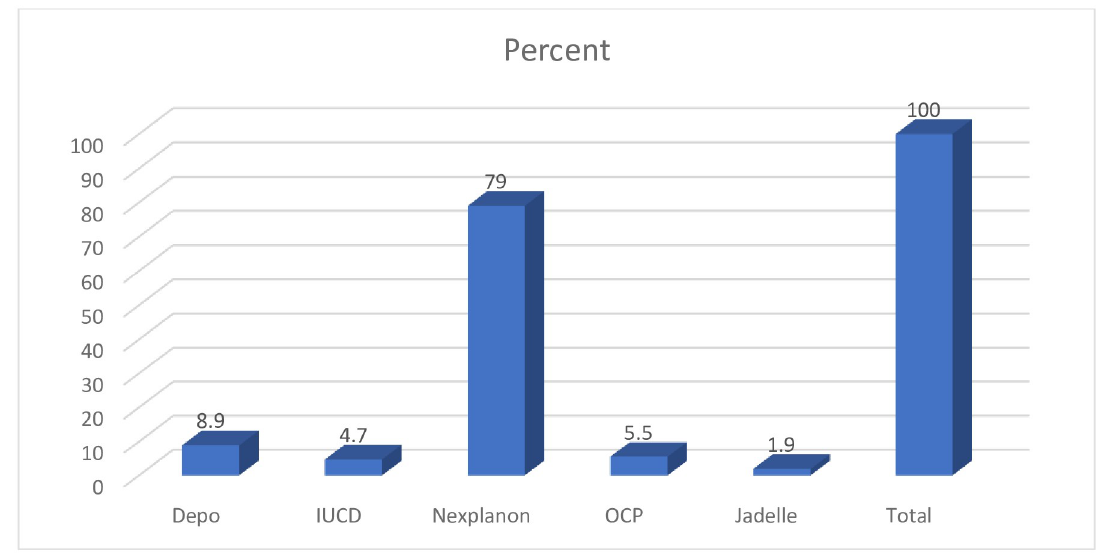
Fig 2. Post abortion family